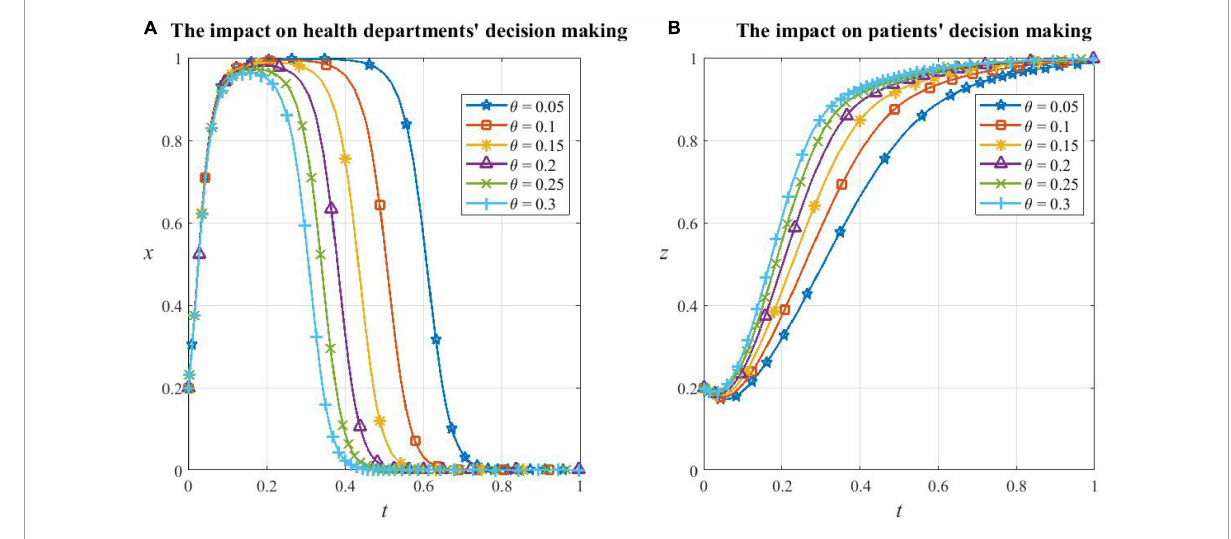
FIGURE8 The impact of additional health insurance reimbursement rate. (A) The impact of additional health insurance reimbursement rate on local government health departments’ decision making, (B) the impact of additional health insurance reimbursement rate on patients’ decision making.